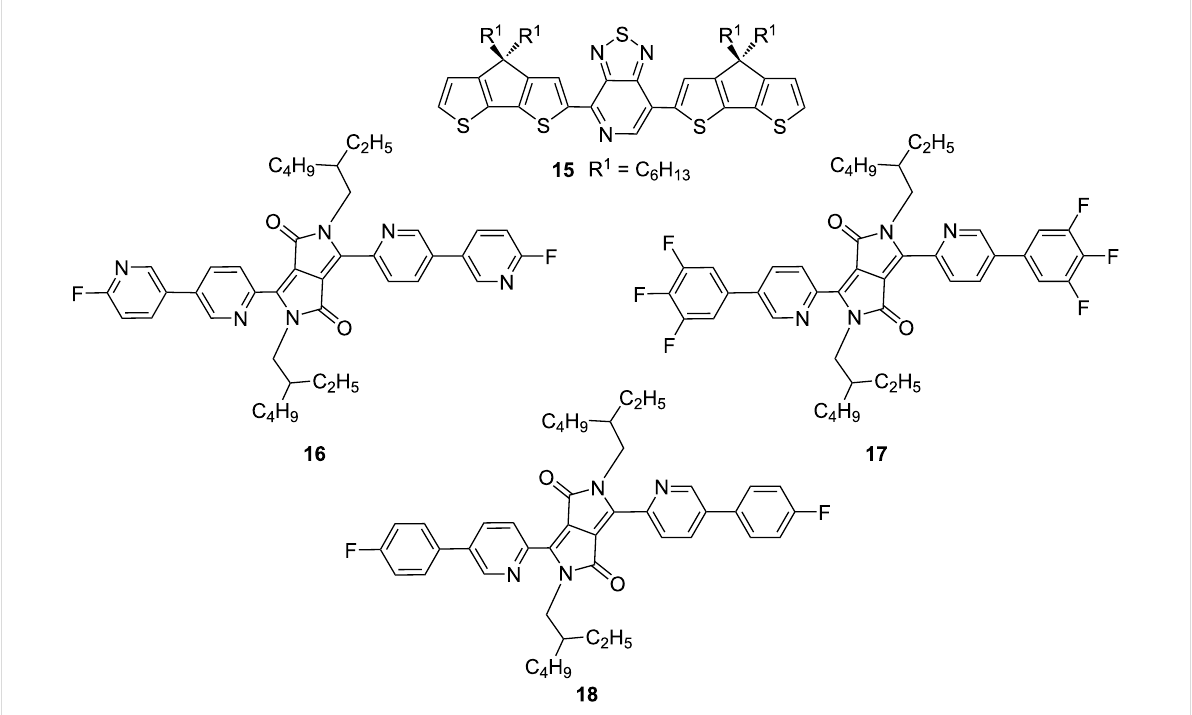
Figure 8: Structure of small molecule 15 containing pyridine and thiazole groups reported by Bazan et al. and pyridine groups-containing diketo- pyrrolopyrroles (DPP) 16 – 18 investigated by Huang et al.